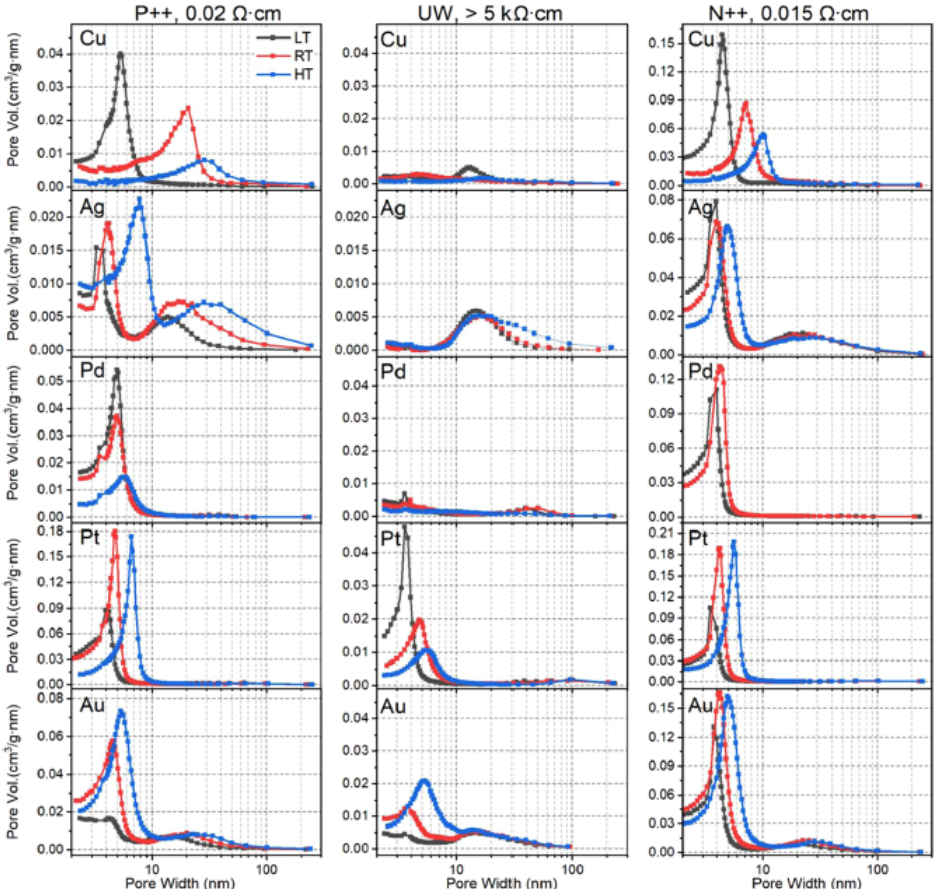
Figure 7. In the low-load regime (LL-MACE), control of the metal composition, doping level and temperature are used to control the pore size distribution. Reproduced with permission from Ref.